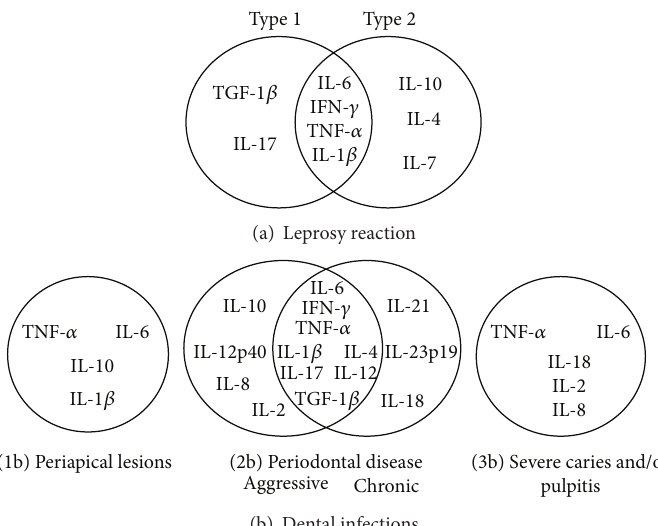
Figure 2: Main inflammatory meditators identified for leprosy reaction (a) and dental infections (b) in articles published between January 1, 1996, and December 1, 2013, and selected for the systematic review.